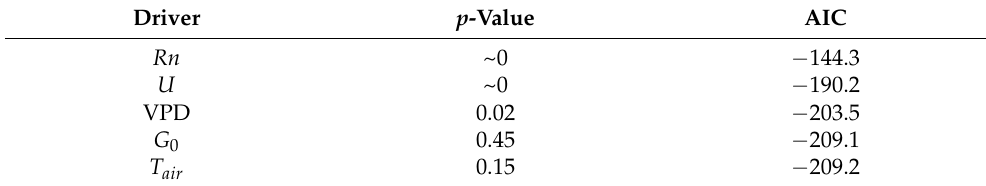
Table 4. Results of the multivariate regression of actual evapotranspiration against the linear combi- nation of the considered drivers. p -values for Student t (threshold set to 0.05) and Akaike information criterion (AIC) values. Illustrated AIC values are prior to AIC stepwise minimisation. All the growing seasons are considered without inter-annual distinctions. R 2 = 0.56 (adjusted value, considering all